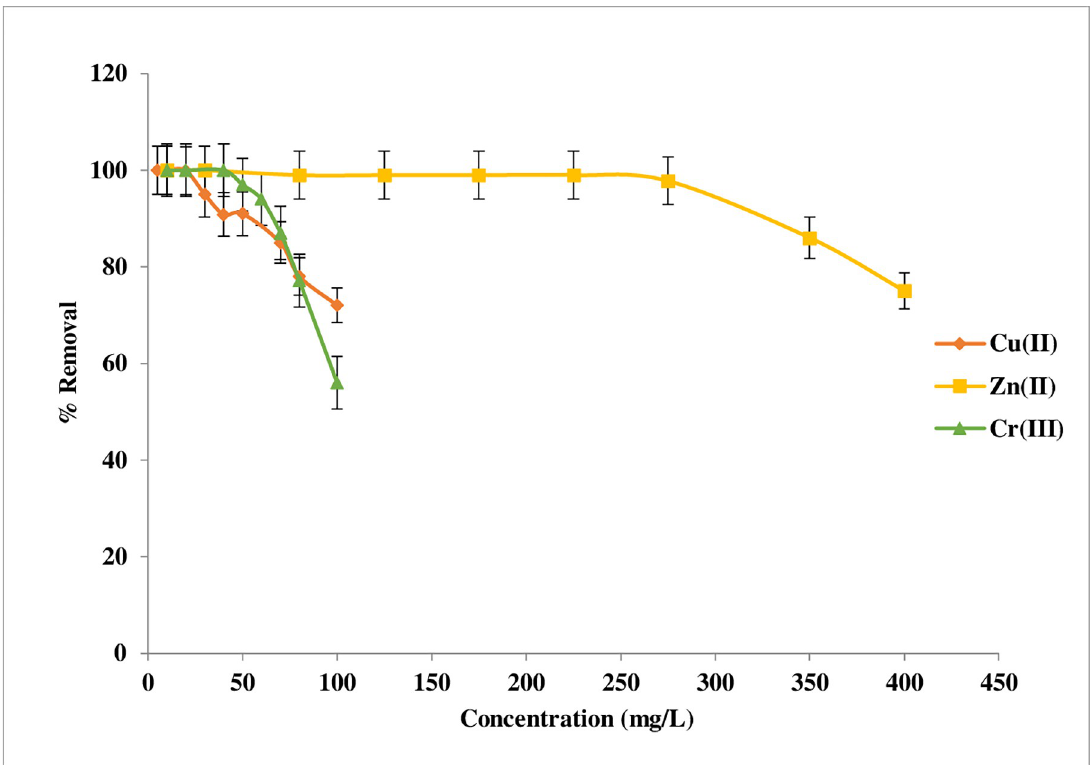
Fig 8. Curve of initial concentration Effect for Cu(II), Zn(II), and Cr(III) adsorption on